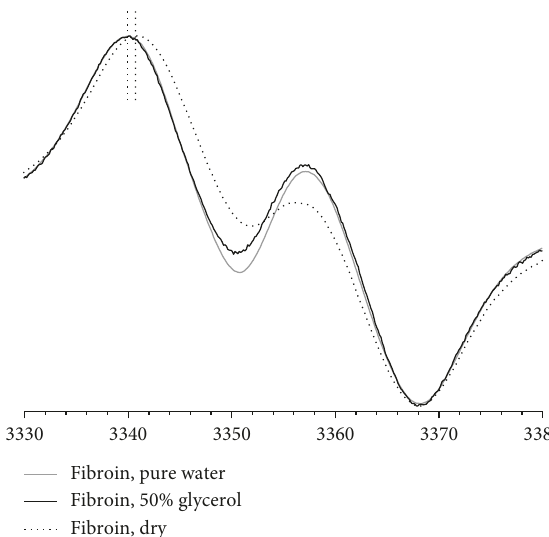
Figure 2: EPR spectra of free radicals induced by UV irradiation of silk fibroin in dry form and immersed in water and 50% glycerol at 77K. For better visualization, both wings of the spectra were